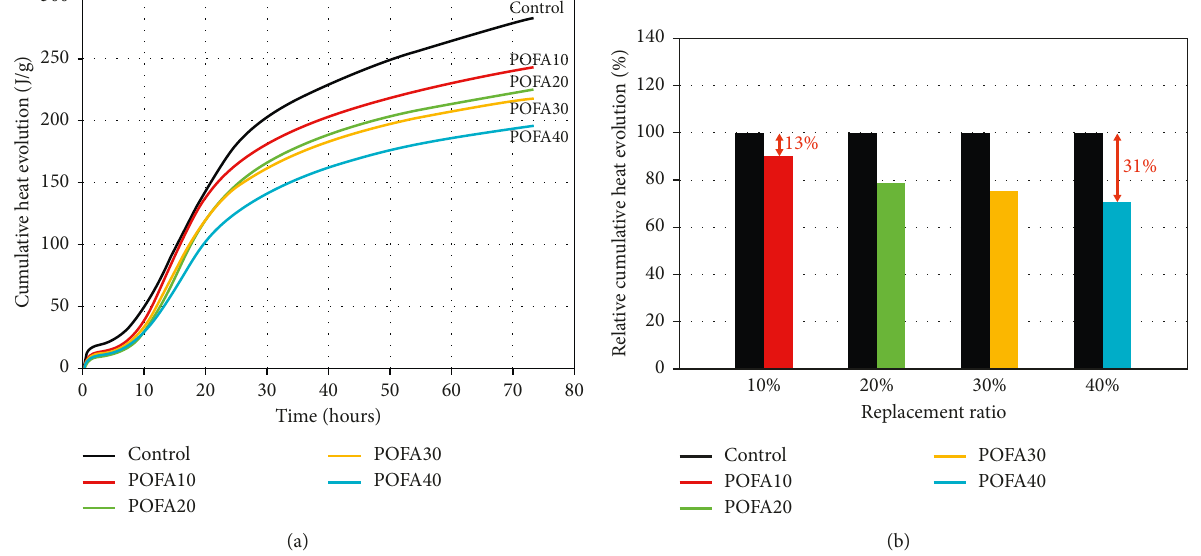
Figure 6: (a) Cumulative heat evolution of mortars containing mPOFA. (b) Relative cumulative heat evolution of mortars containing mPOFA.